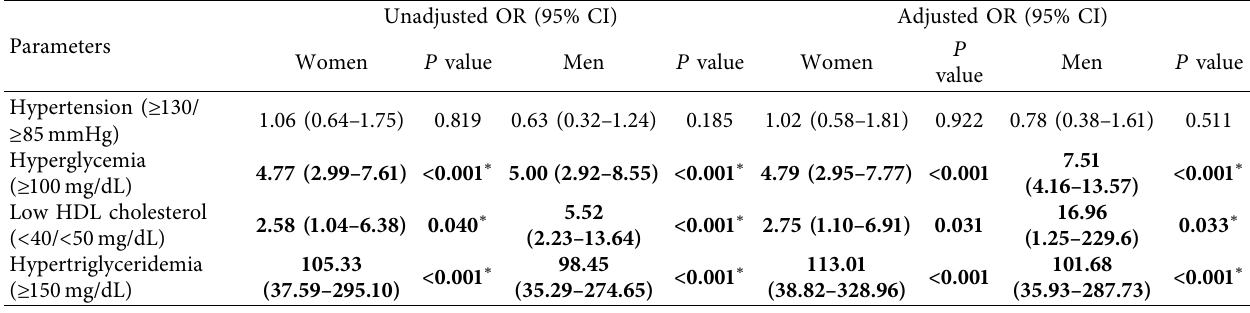
Table 3: Logistic regression analysis evaluating the sex differences in the association between the TyG index and cardiovascular risk factors in the MONW